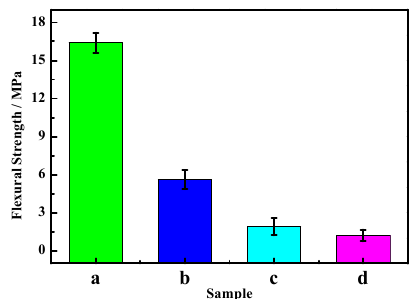
Figure 8. Flexural strength of the MOC samples after different dry–wet cycles: (a) without dry–wet cycles; (b) one time; (c) two times; (d) three times.